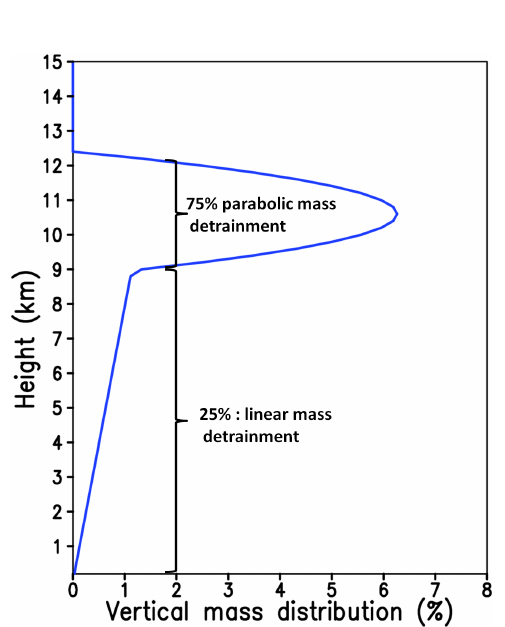
Fig. 1. The vertical profile of the ash cloud mass distribution (%) associated with an eruption with 12km height above the vent. In this case the cloud base is located around 9km height above the vent. Note the umbrella cloud detrainment layer represented as a parabolic mass distribution with 75% of the erupted mass. The 25% of the erupted mass is linearly detrained from the umbrella base to the vent height. event of eruption, are shown in Fig. 2. This figure shows the geographical location in the world and also depicts the pre- scribed plume height above the